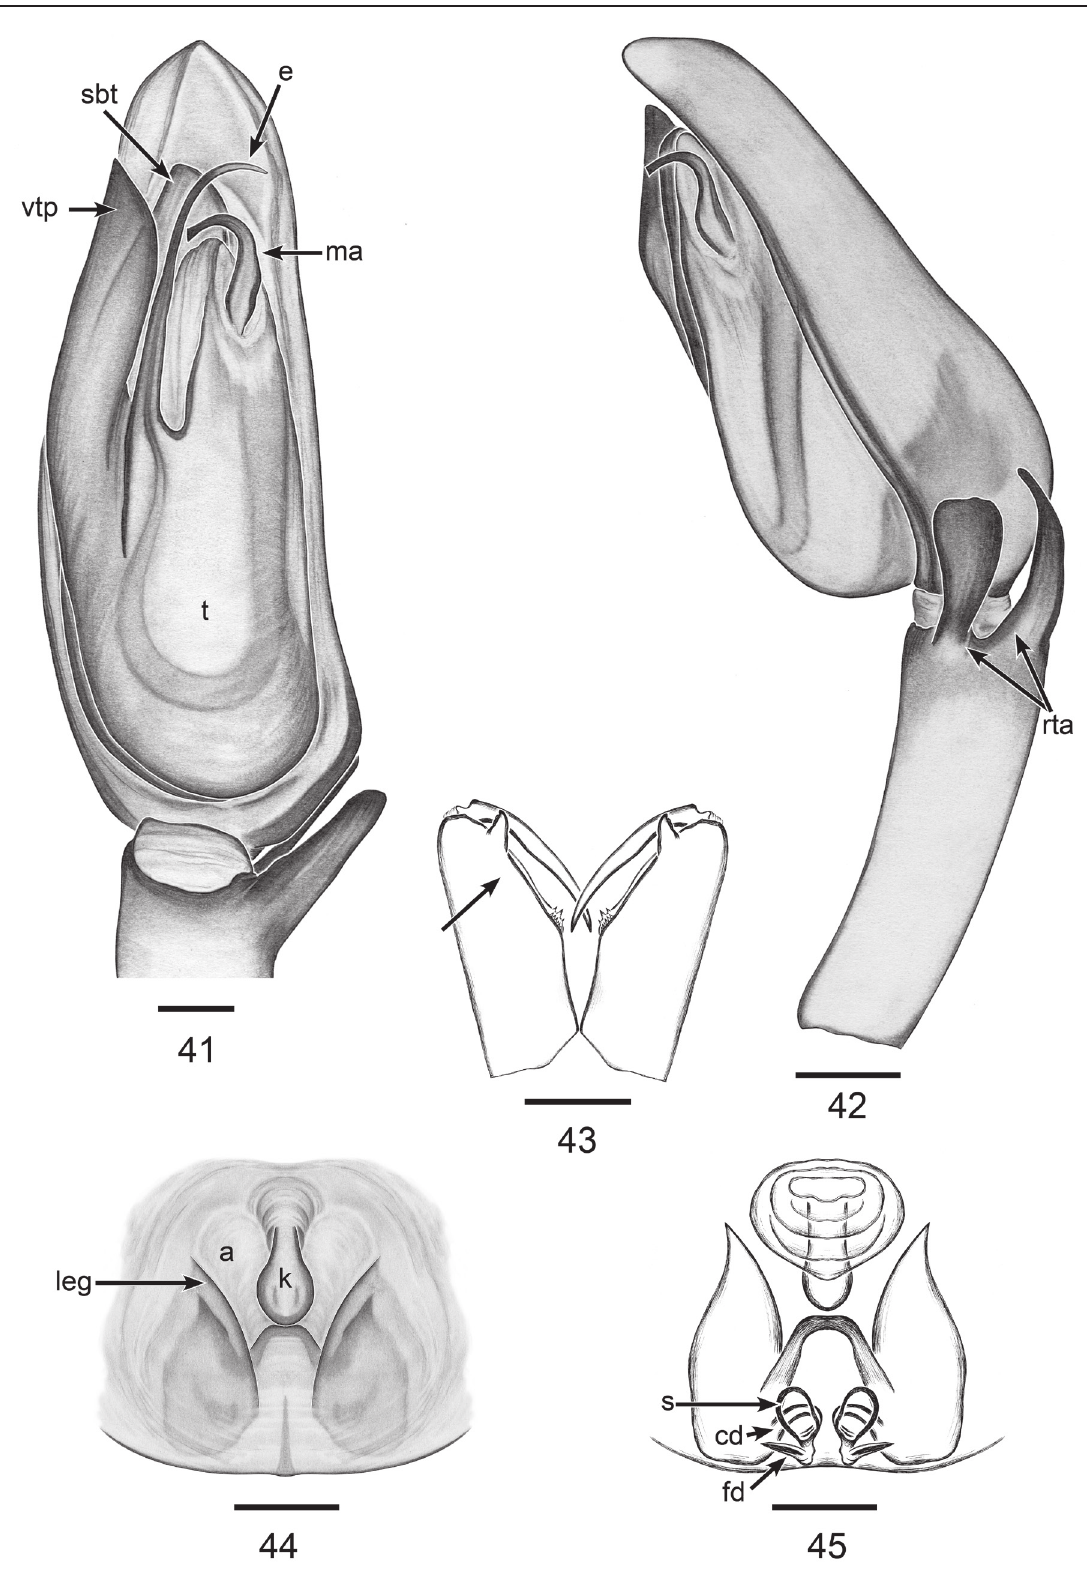
Figs 41–45. Patrera philipi sp. nov. 41 . ♂, palp, ventral view. 42 . ♂, palp, retrolateral view. 43 . ♂, chelicerae, posterior view. 44 . ♀, epigynum, ventral view. 45 . ♀, internal genitalia, dorsal view. Scale bars: 41–42, 44–45 = 0.1 mm; 43 = 0.5